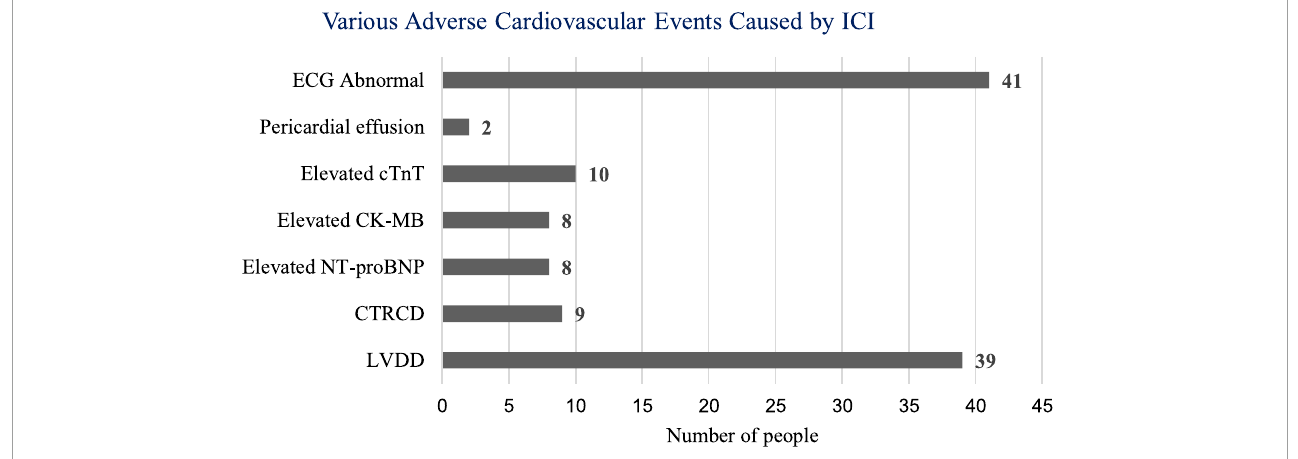
FIGURE1 Number of adverse cardiovascular events caused by immune checkpoint inhibitors (ICI). ECG, electrocardiogram; cTnT, cardiac troponin T; CK-MB, creatine kinase isoenzyme-MB; NT-proBNP, N-terminal pro brain natriuretic peptide; CTRCD, cancer therapy-related cardiac dysfunction; LVDD, LV diastolic